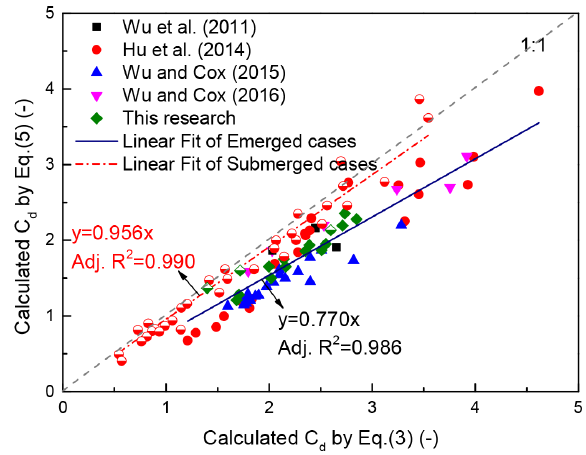
Figure 6. Comparison of the calculated values of C D by Eq. (3) and the new method. Different symbols indicate cases from different research studies. The solid line indicates linear fit of all cases.